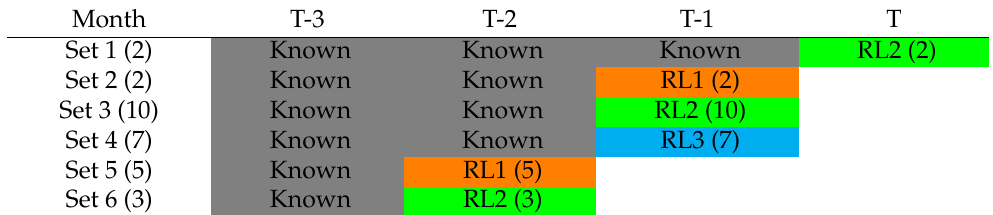
Table 5. Data releasing structure in the empirical study when nowcasting quarter K + 1’s GDP in month T . RL stands for release, with release 1 colored in orange, released 2 colored in green, and release 3 colored in blue. The number in parentheses represents number of series for that particular release.